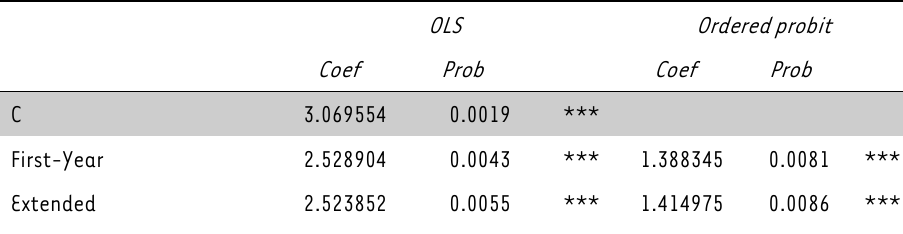
Concluding estimated well-being model OLS Ordered